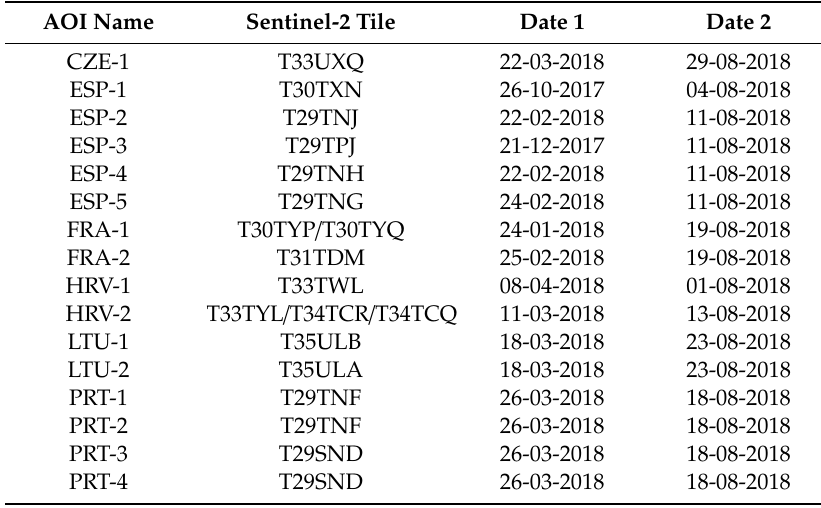
Table 1. Tile and acquisition date of Sentinel-2 imagery used to generate the validation